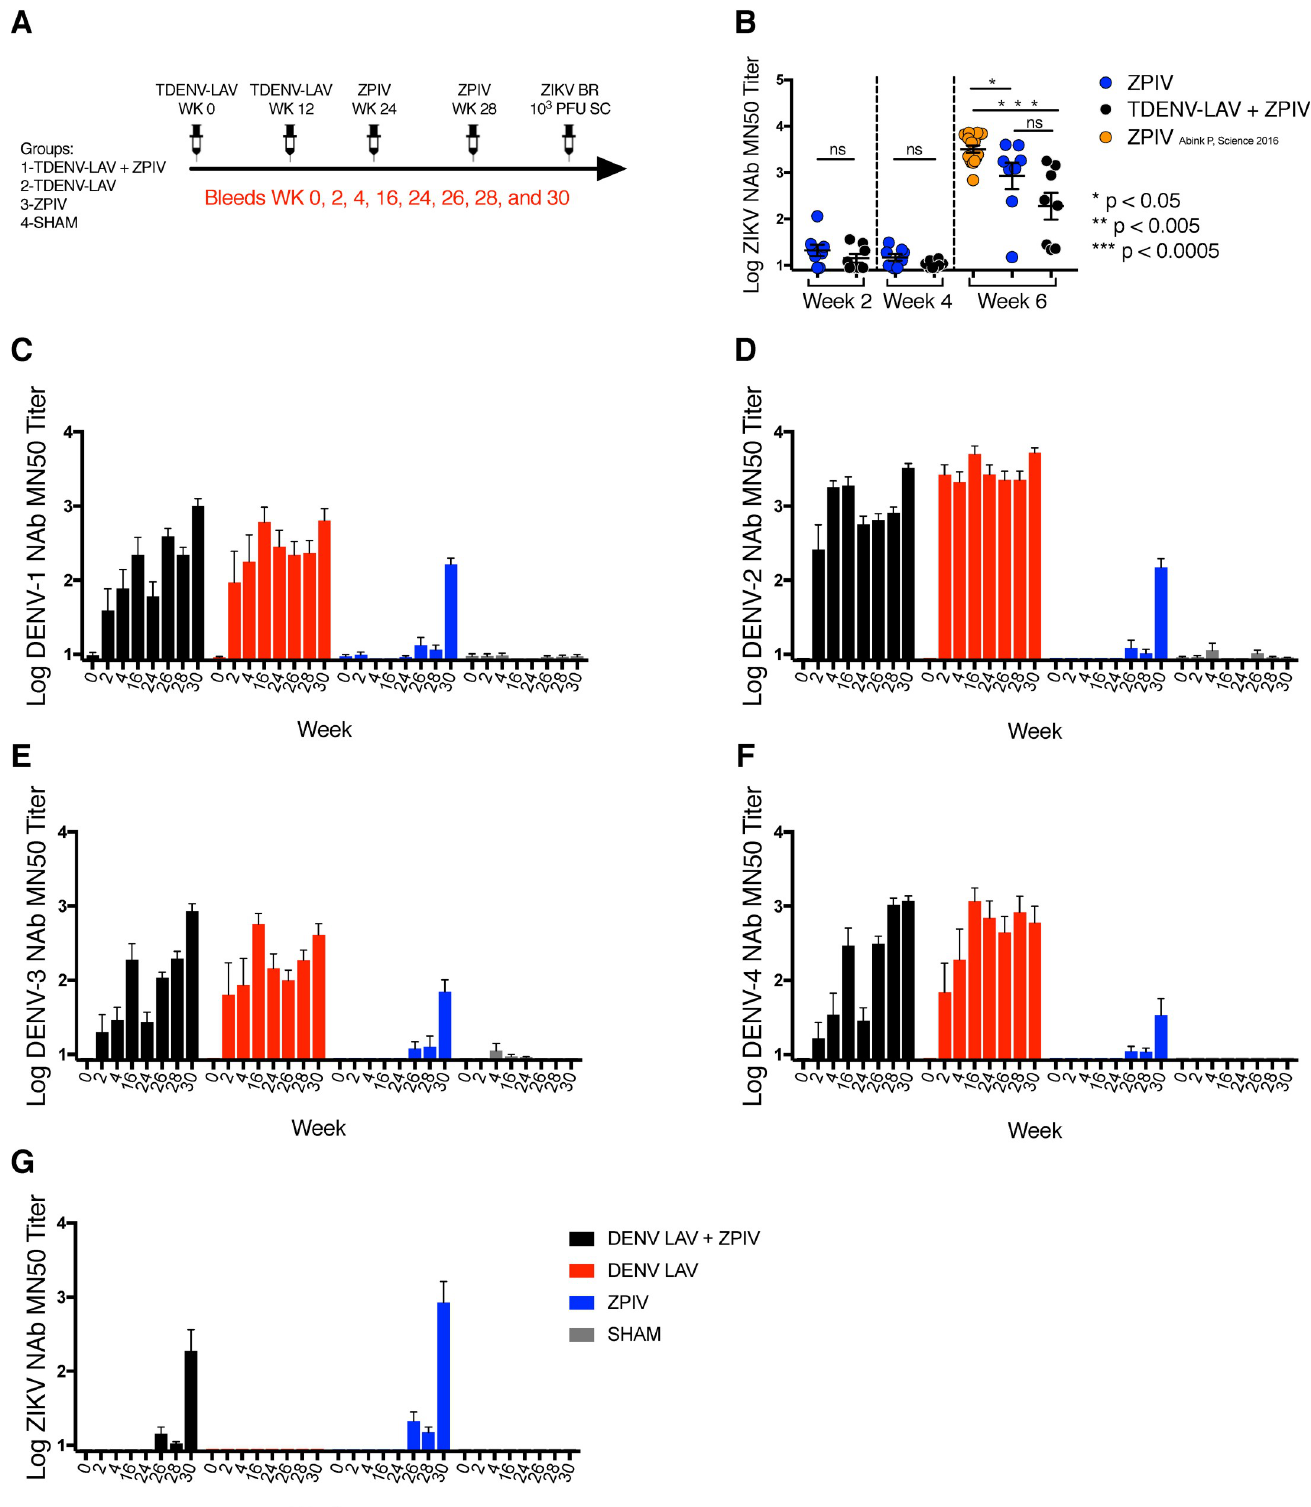
Fig 1. Induction of Neutralizing antibodies by TDENV-LAV and ZPIV vaccines in rhesus monkeys. (A) Study Schematic Design. Monkeys (distributed into 4 groups, n = 8 per group) were immunized intramuscularly (i.m.) on weeks 0 and 12 with 10 3 PFU of the live attenuated tetravalent DENV vaccine (TDENV-LAV)